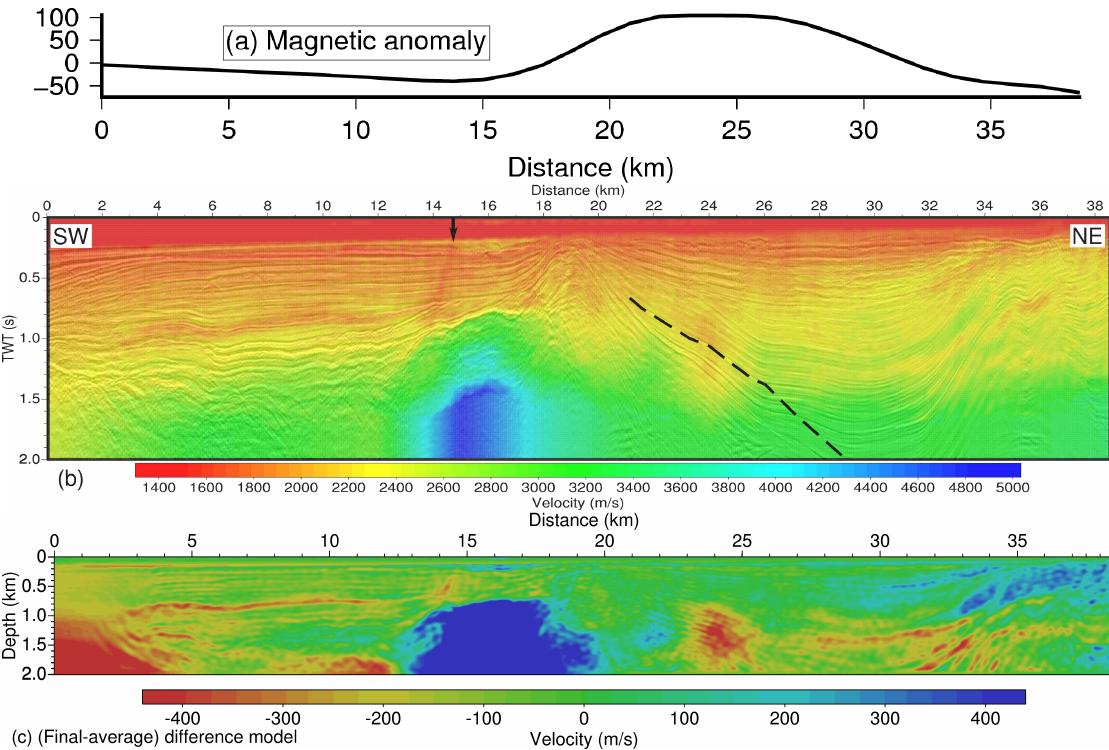
Figure 19. ( a ) Variation of magnetic anomaly along line 89-06. ( b ) Migrated seismic section with final velocity model superimposed. Black arrow indicates possible (?) gas migration pathway and black dashed line indicates approximate location of Tofino fault. ( c ) Final velocity model minus the average 1D-velocity model. Velocities are clipped at 400